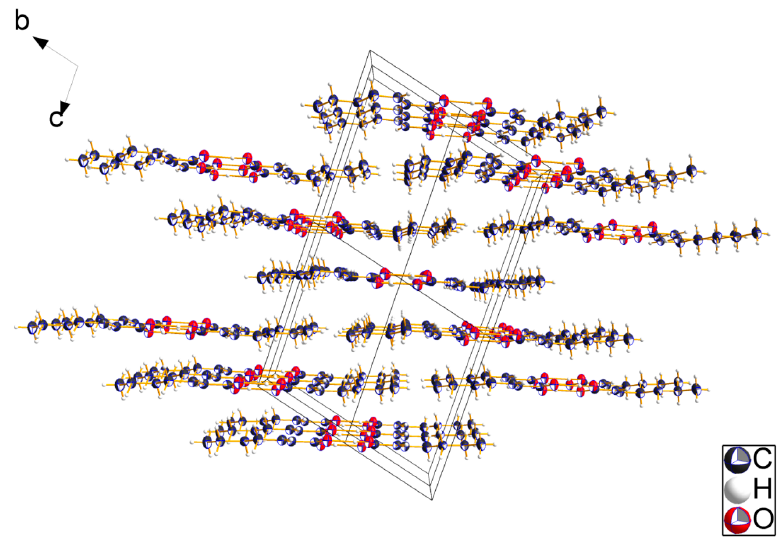
Figure 4. View of the packing of acid dimer layers in the crystal of C7 along the crystallographic a axis.